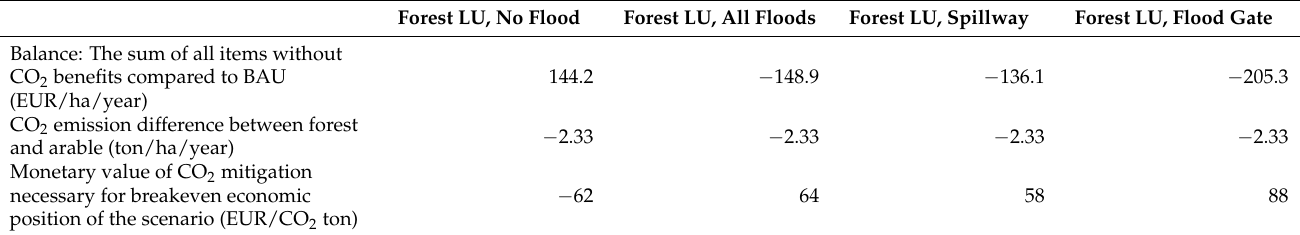
Table 7. Carbon sink breakeven price in the forest scenarios. Source: Own calculations. Forest LU, No Flood Forest LU, All Floods Forest LU, Spillway Forest LU, Flood